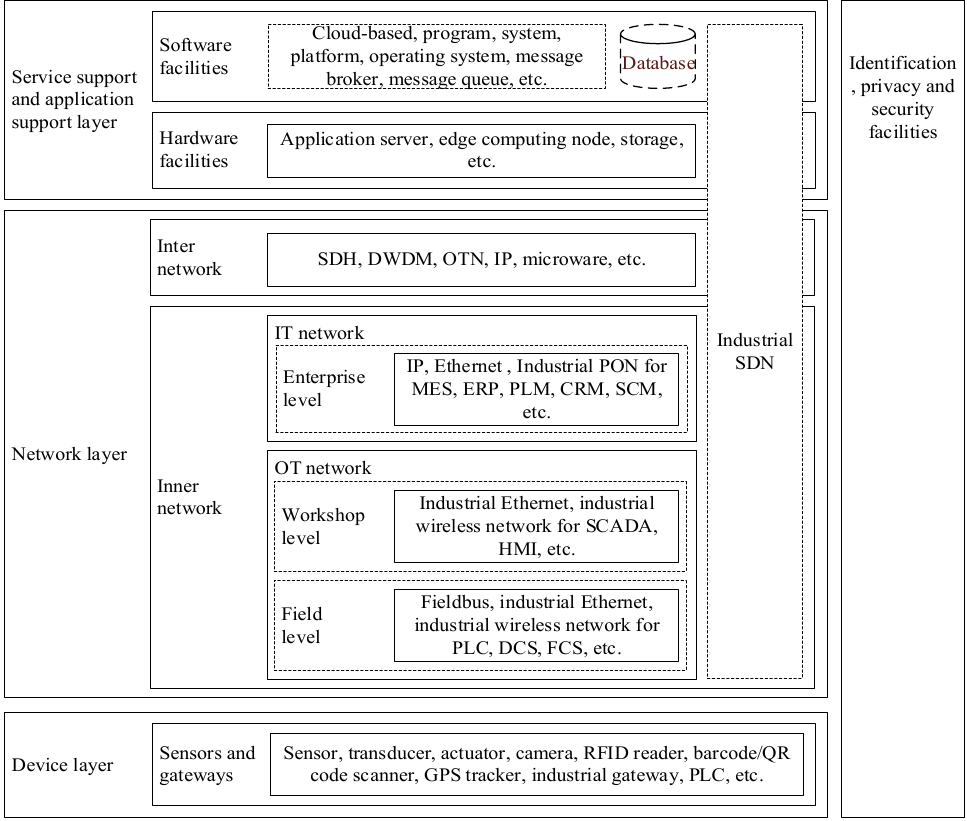
Figure 1. Conceptual framework of the IIoT infrastructure from the IoT and SM points of view.